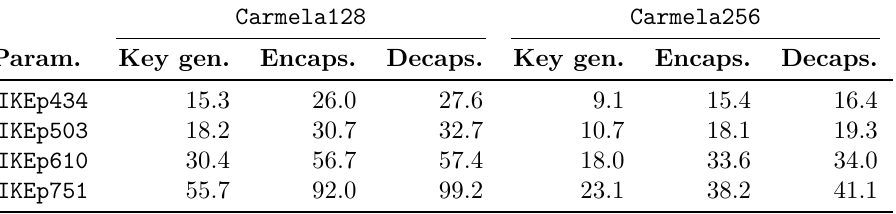
(b) Results on the Artix 7